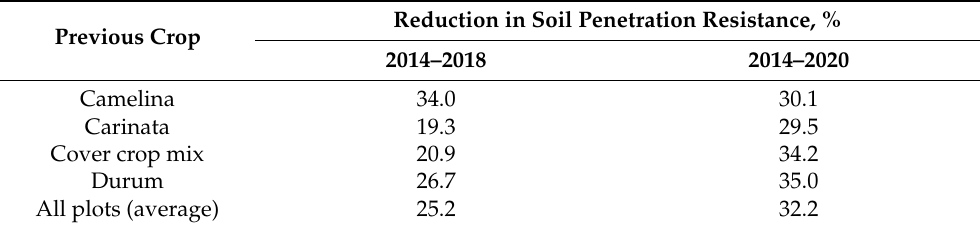
Table 4. Reduction in soil penetration resistance in the compacted layer (8–20 cm) for durations